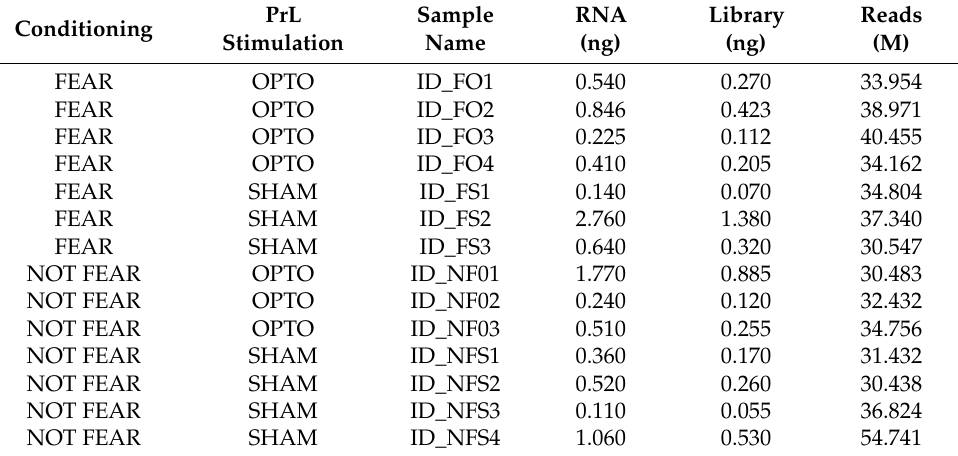
Table 5. Sketch of RNA samples extracted by amygdala pyramidal YFP neurons and sequenced in PE75 mode. Only samples used for sequencing, i.e., 14 over the total, are reported. The samples that did not pass quality control were excluded from further